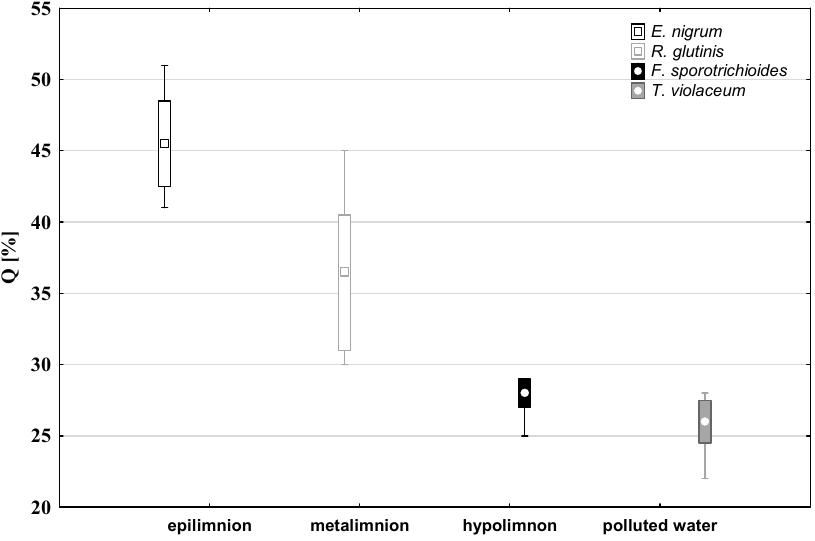
Figure 1. Values of the indicator of ecological significance (Q) of select mycoplankton species. Rhodotorula glutinis showed a directly proportional relationship between its abundance and algae biomass and the abundance of bacteria. An inversely proportional relationship was observed for Epicoccum nigrum (Figure 2).